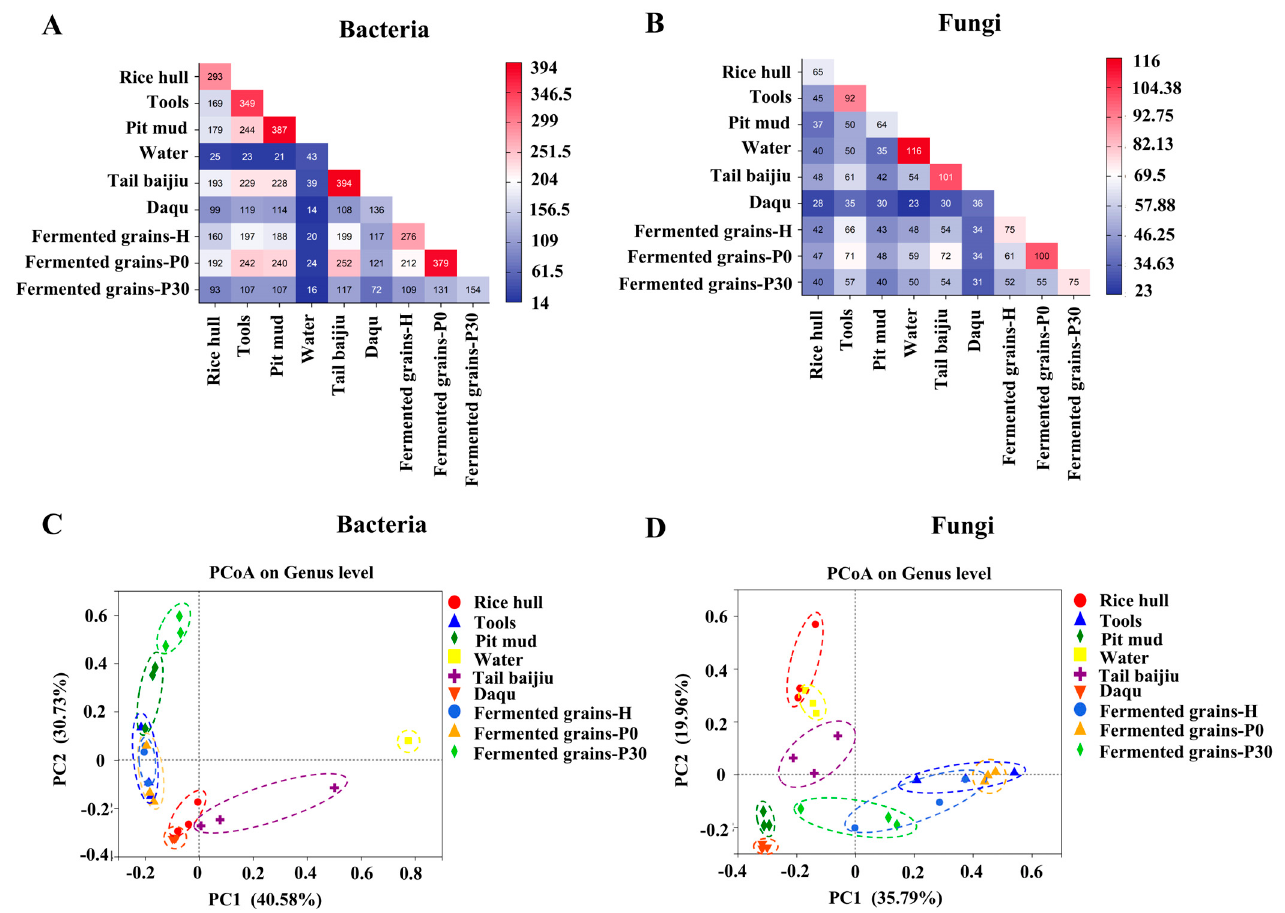
Figure 2. Sharing of microbial taxa among samples: ( A ): Shared bacterial taxa; ( B ): Shared fungal taxa and Beta diversity assessed by using unweighted UniFrac principle coordinate analysis (PCoA) plot based on genus level (( C ): Bacteria; ( D ): Fungi).